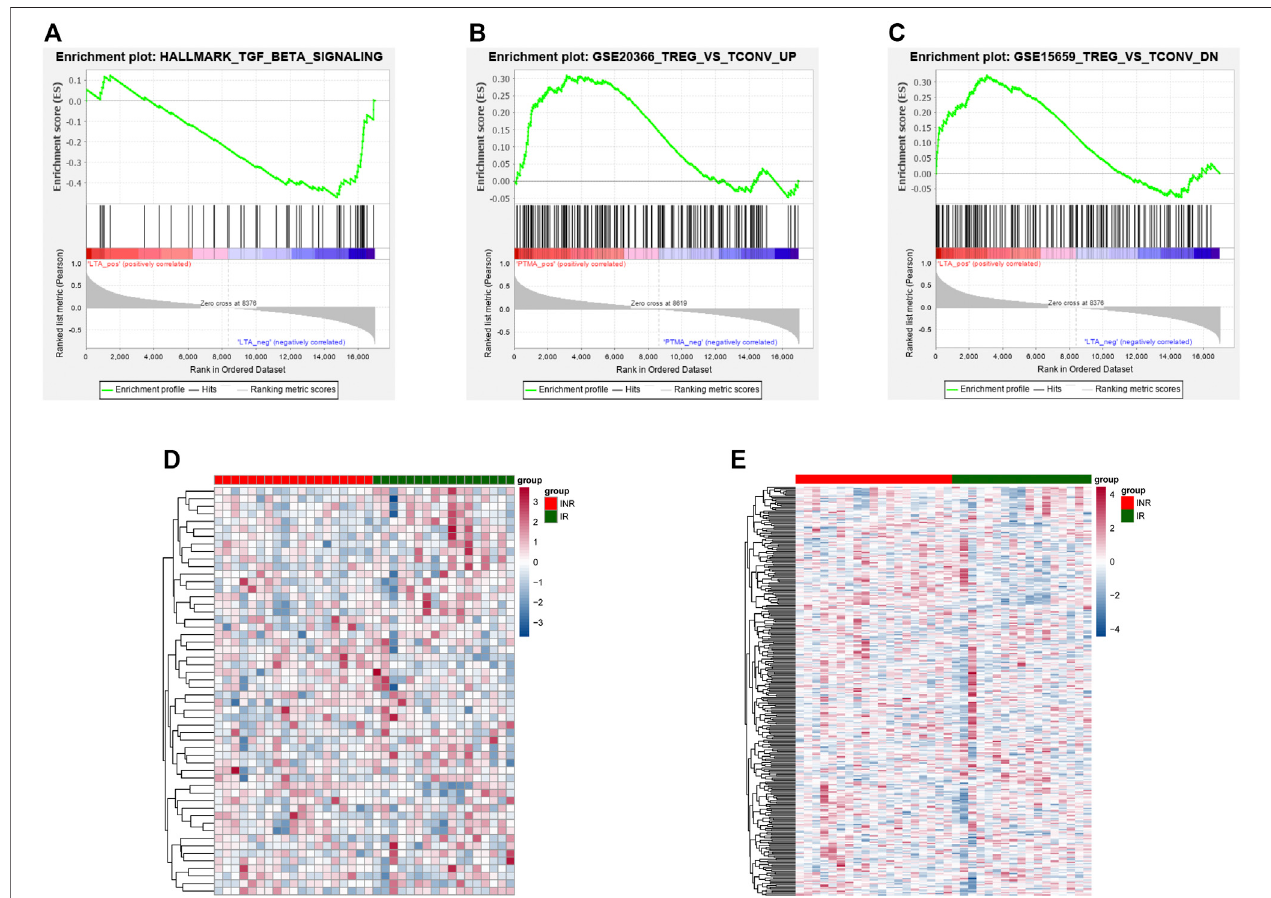
FIGURE 4 | The results of enrichment analyses of diagnostic markers. (A) HALLMARK_TGF_BETA_SIGNALING pathway enriched by LTA. (B – C) TREG_VS_TCONV_UP and TREG_VS_TCONV_DN pathway enriched by PTMA (B) and LTA (C) . (D) The expression of genes in the HALLMARK_TGF_BETA_SIGNALING pathway between INRs and IRs. (E) The expression of genes in TREG_VS_TCONV_UP and TREG_VS_TCONV_DN pathway between INRs and